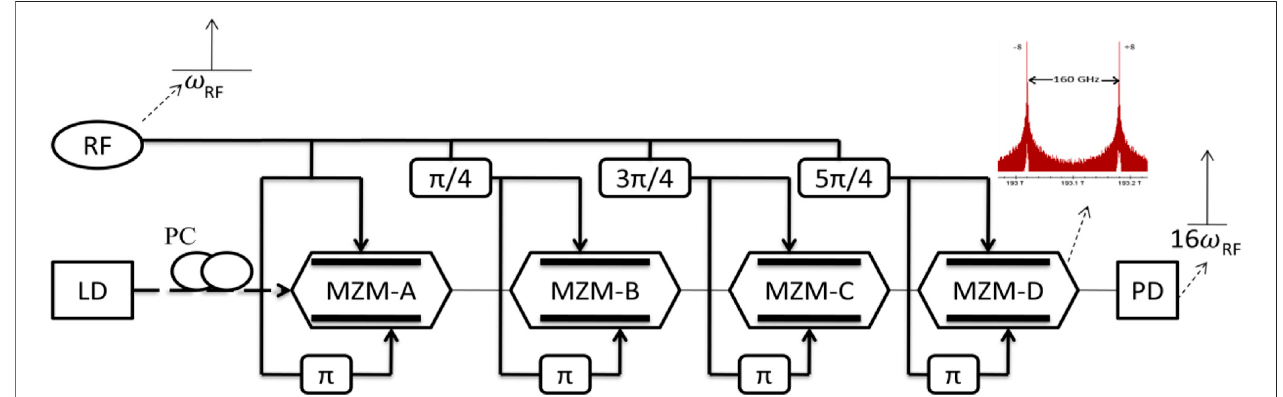
FIGURE 1 | Proposed structure for generating a 16-tupled MM wave